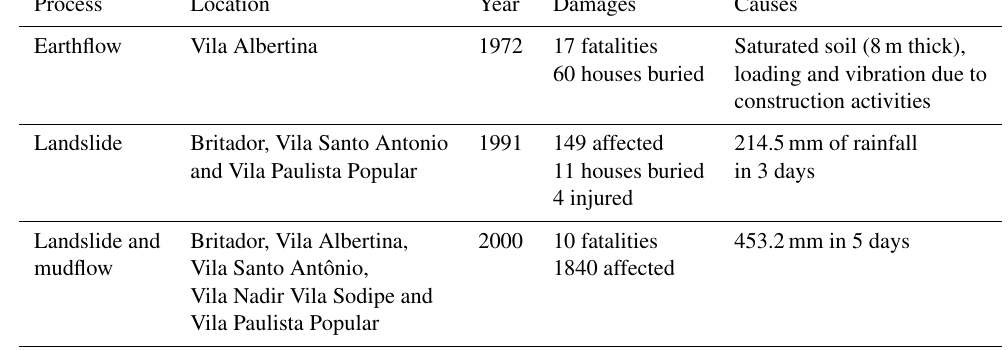
Table 1. Historical disasters in Campos do Jordão municipality. Source: Ridente et al. (2002) and Andrade (2014).